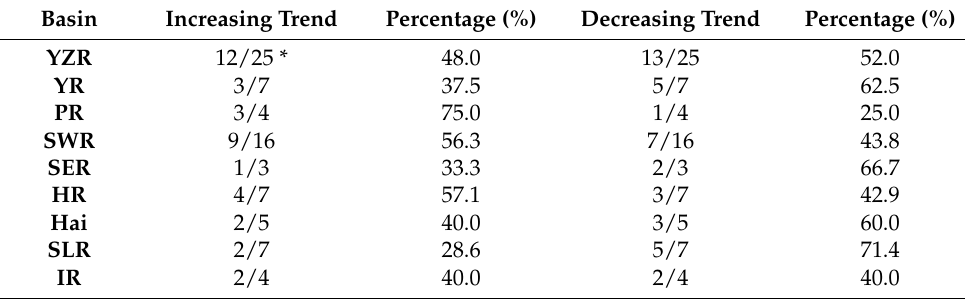
Figure 7. Standardized runoff index on a 3-month scale (SRI-3) trends for 79 stations from 1996–2016. Table 2. Statistics of SRI-3 trends for the selected 79